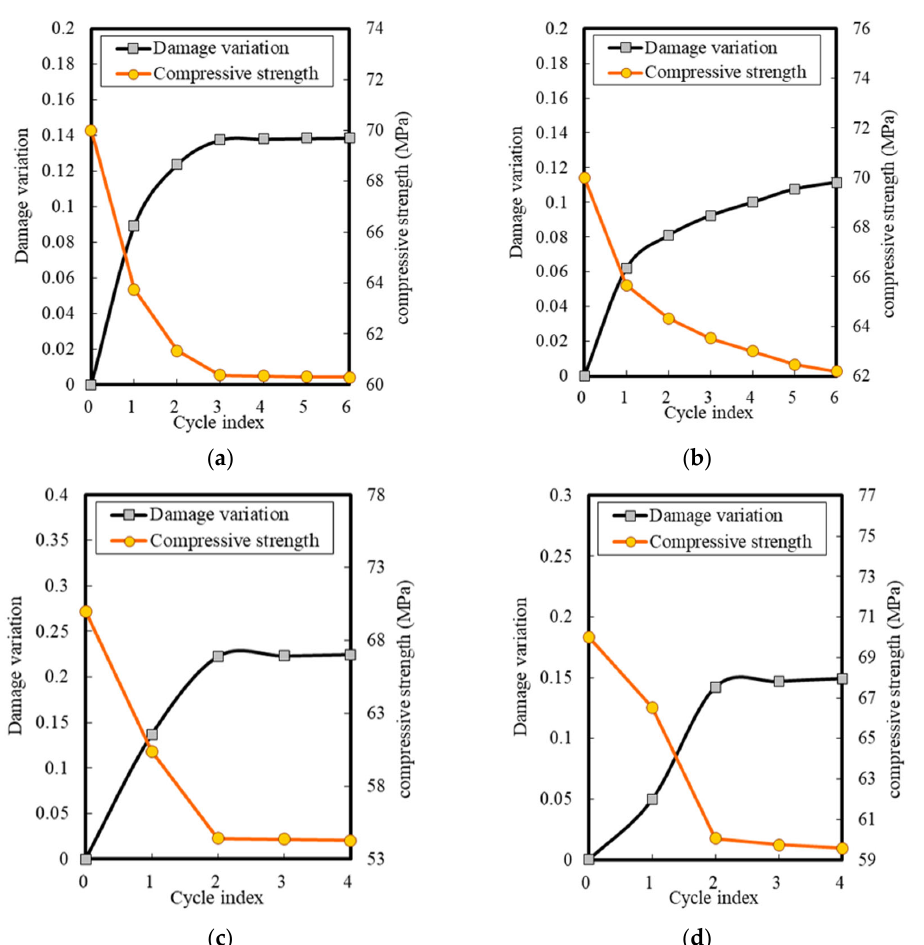
Figure 3. Variation of damage variable and rock compressive strength under cyclic loading. ( a ) 1# core; ( b ) 2# core; ( c ) 3# core; ( d ) 4# core.